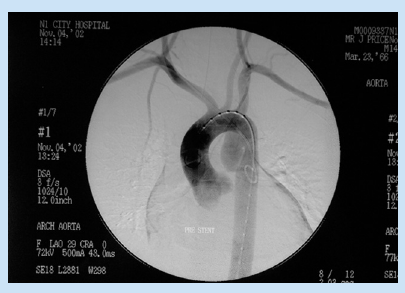
Fig. 3a. Post-traumatic pseudo-aneurysm in a 22- year-old male post motor vehicle accident.